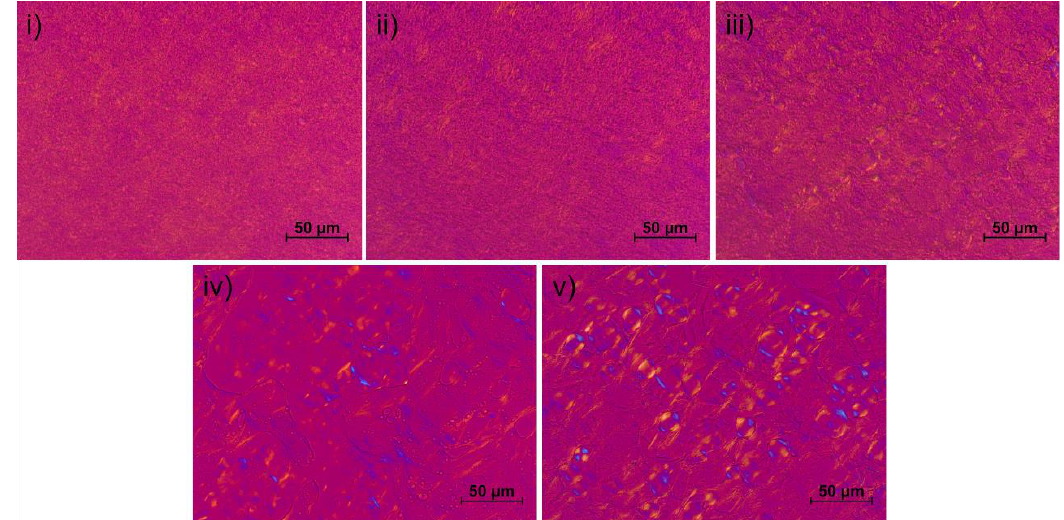
Figure 7. Polarization microscopic images of the formulations stored over 6 months: ( i ) pure NHC, ( ii ) 2-methyl-2,4-pentanediol 5%, ( iii ) 1,2-pentanediol 5%, ( iv ) 1,2-hexanediol 5%, ( v ) 1,2-octanediol 1%.